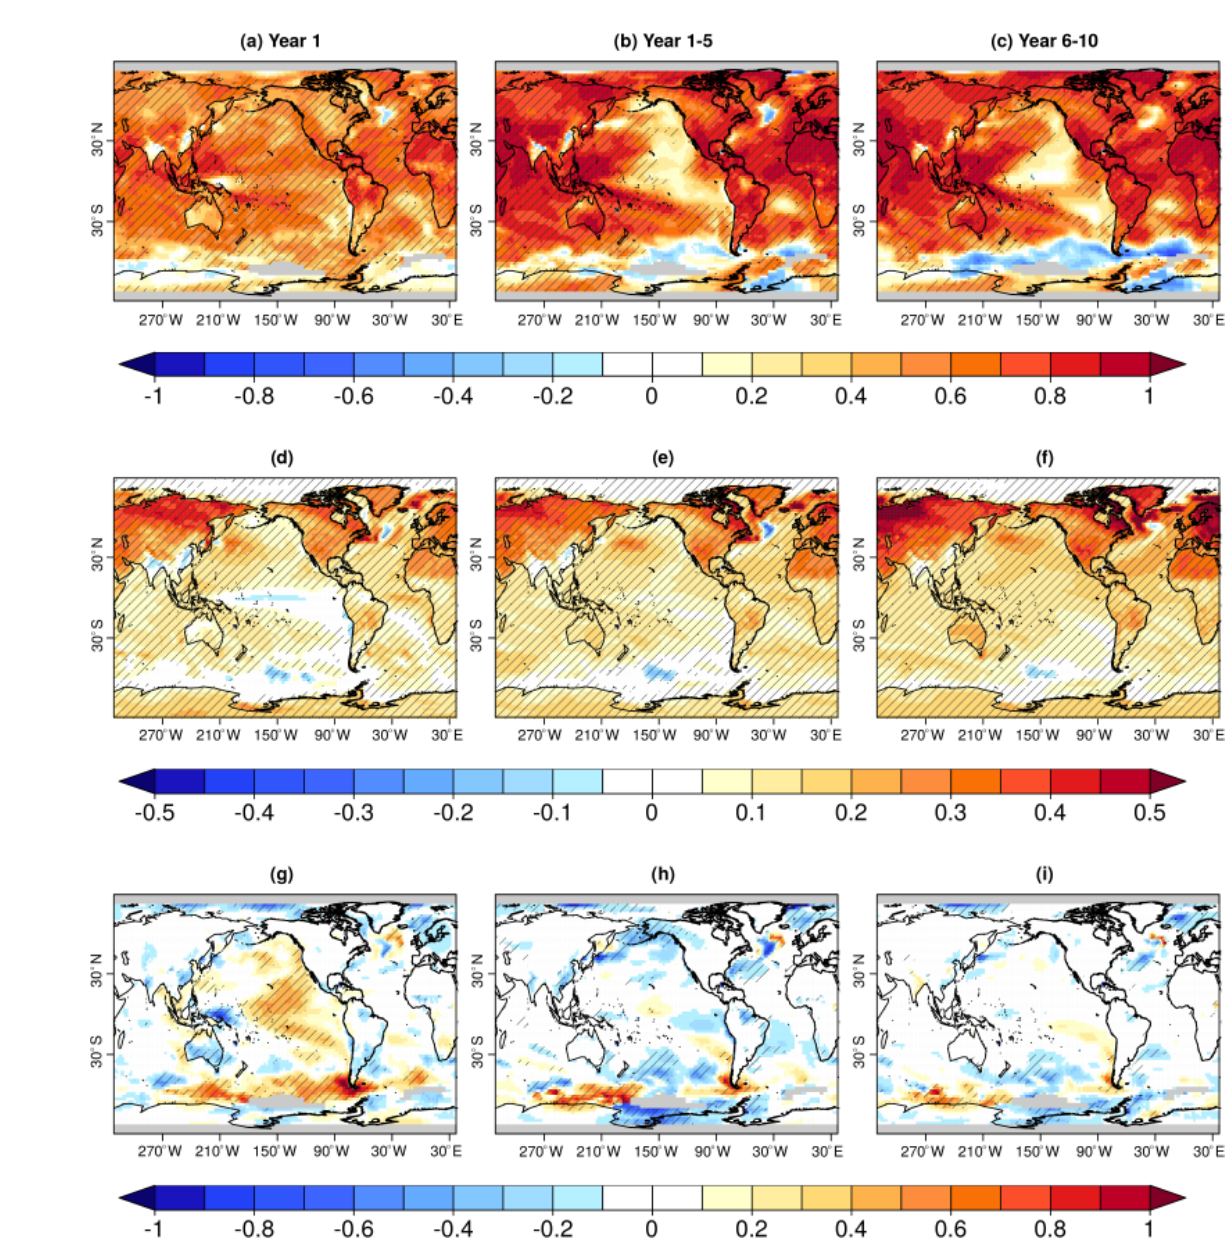
Figure 2. Anomaly correlation coefficient (ACC) for the annual surface temperature (SAT and SST blend) in PRED for forecast years (a) 1, (b) 1–5 and (c) 6–10. The ACC is computed between the model ensemble mean of the blended SAT (over land) and SST (over the ocean) fields and GISTEMPv4. Grid points with missing values in observations are masked in grey. Panels show surface temperature linear trends (in K per decade) in PRED for the same forecast years as in panels (a–c) . Panels (g–i) show the ACC difference between PRED and HIST in the same forecast years as above. In all rows, hatching indicates significance at the 95% confidence level. Both ACC and trends are computed for annual mean values of all available years for the respective forecast period referenced to the 1970–2018 climatology.